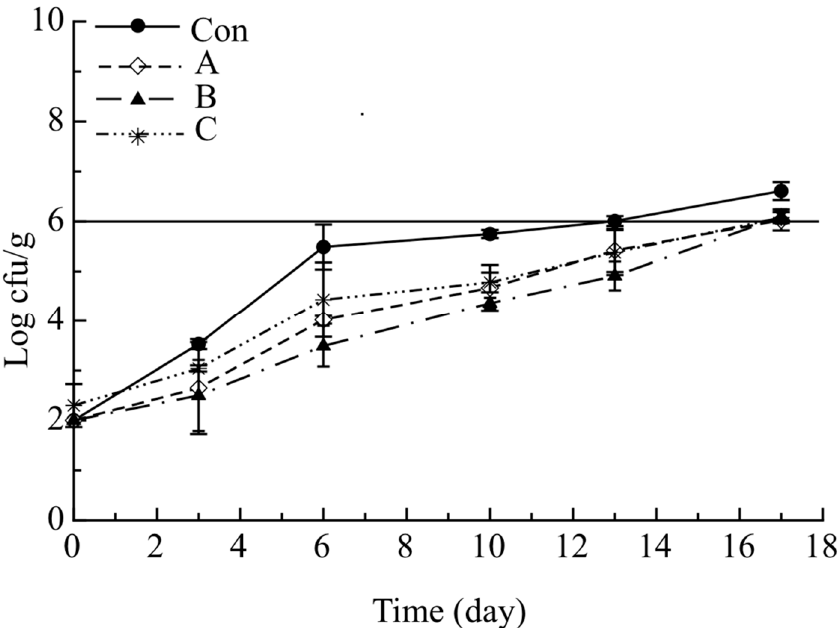
Figure 2. Evolution of Pseudomonas spp. in breaded cod sticks during storage at 4 °C. Data are presented as mean ± SD ( n = 2). Symbols: experimental data; Solid Line: threshold for microbial acceptability set to 10 6 log cfu/g. Con: sticks breaded with sole no active mix; A: sticks breaded with sole active mix; B: sticks breaded with pomegranate peel powder/no active mix; C: sticks breaded with pomegranate peel powder/active mix.